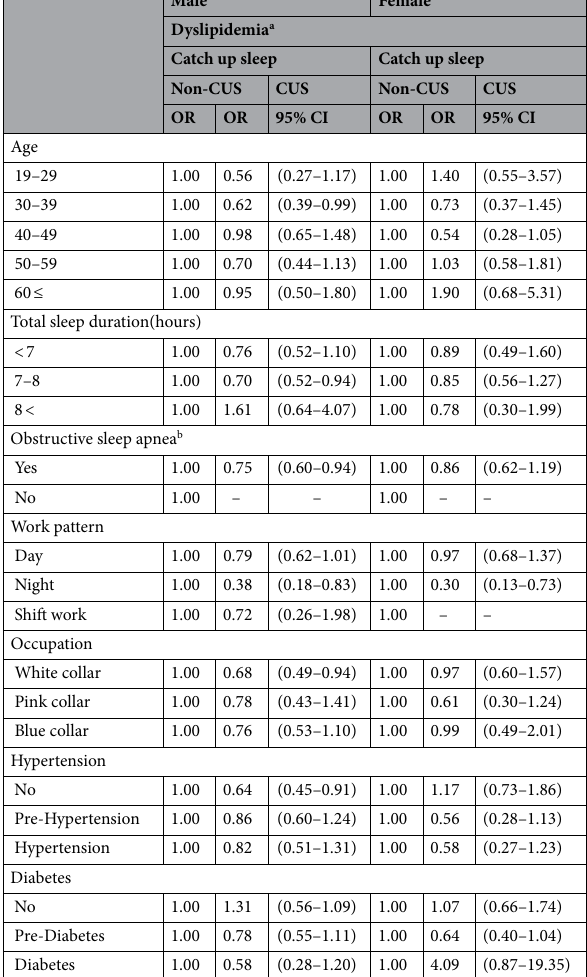
Table 3. Results of subgroup analysis stratified by independent variables. a One of the following four criteria was required: (1) total cholesterol ≥ 240 mg/dL, (2) HDL cholesterol ≤ 40 mg/dL, (3) LDL cholesterol ≥ 160 mg/ dL, or (4) triglycerides ≥ 200 mg/dL. b Only for over 40 years of